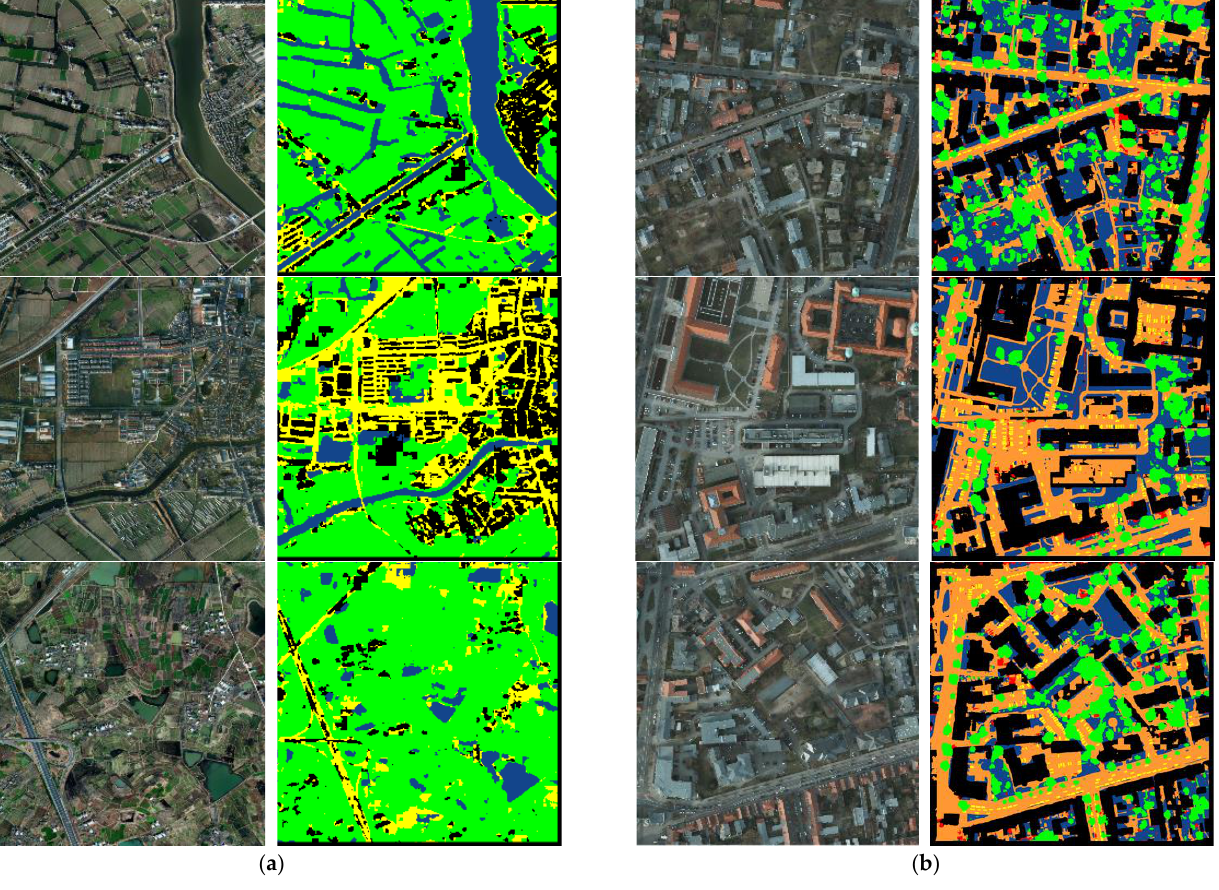
Figure 18. The overall visualization results of the test images provided by ( a ) the BDCI 2017 dataset and ( b ) the ISPRS Potsdam dataset, where the category details are shown in Table 8.